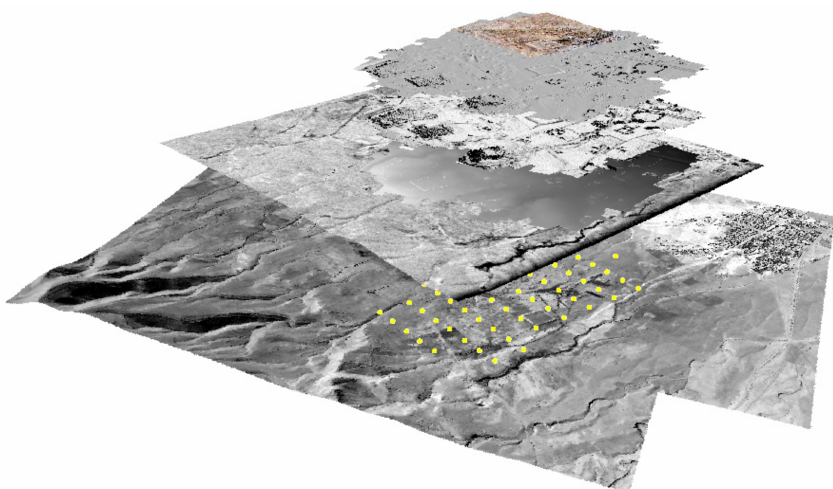
Figure 4. Re-georeferencing of GIS base layers and rectification to the most accurate topographic and hypsometric base layer—point layer, measured directly in the field by sub-metric GPS (author: Lenka Starkov á